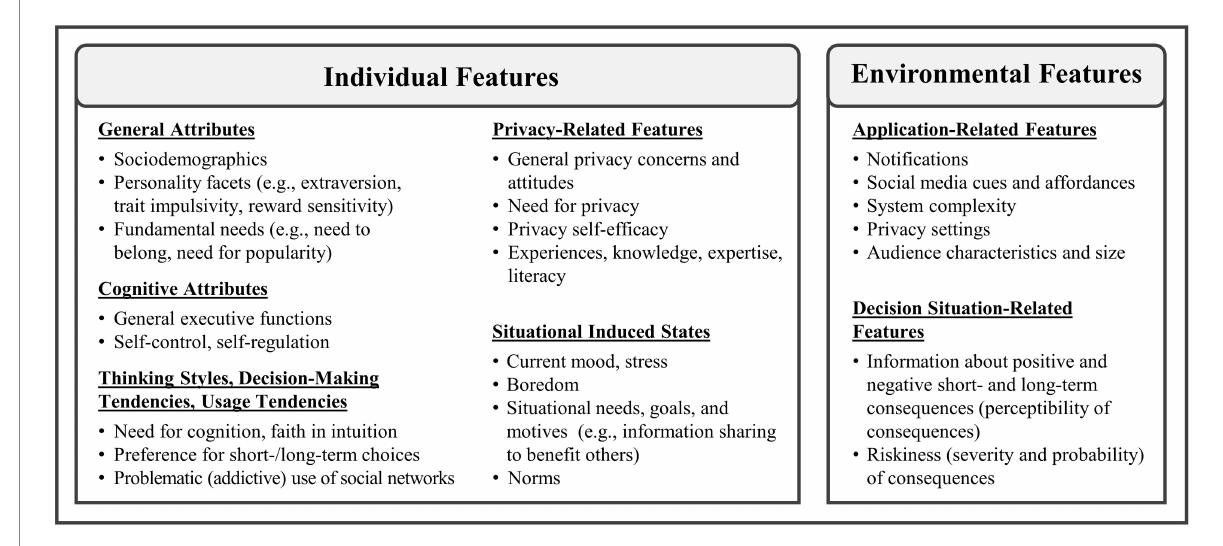
FIGURE 2 Selection of individual and environmental features relevant for self-disclosure decision making on social